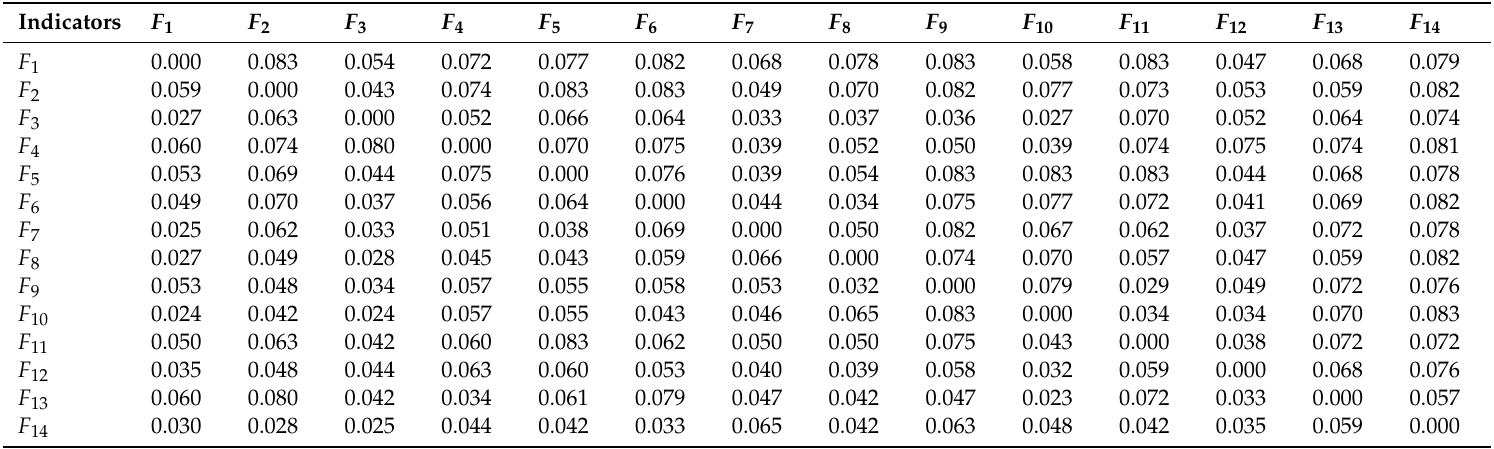
Table 6. The normalized direct relation matrix X .